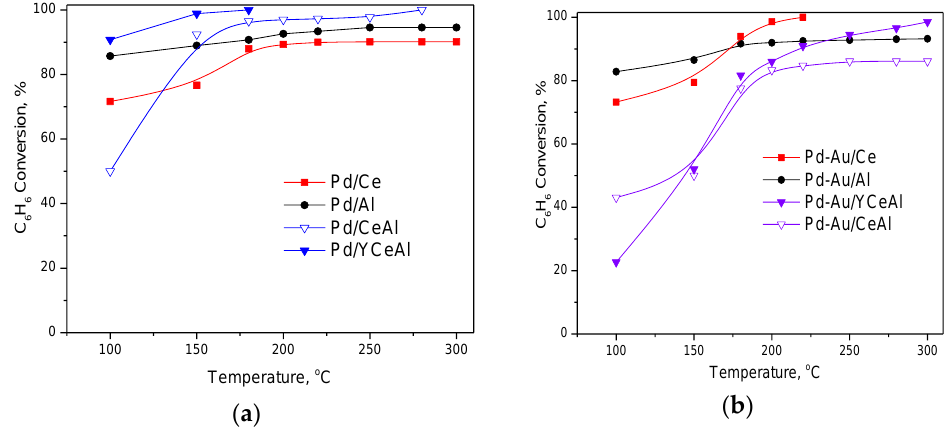
Figure 2. Temperature dependence of CBO over: ( a ) monometallic Pd-based; ( b ) Pd-Au bimetallic catalysts.